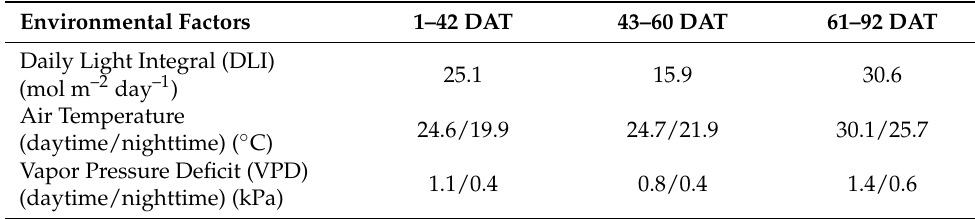
Table 1. Environmental conditions during a 92-day experimental period.